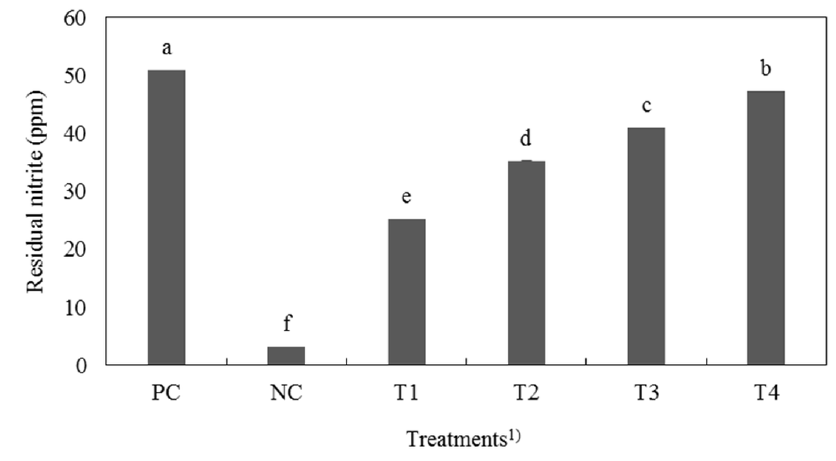
Figure 2. Residual nitrite contents of cured pork loin with natural nitrite source from fermented Swiss chard (FSC). 1) PC, positive control, 120 ppm nitrite; NC, negative control, nitrite-free; T1, FSC solution:water = 10:30; T2, FSC solution:water = 20:20; T3, FSC solution:water = 30:10; T4, FSC solution:water = 40:0. a-f Different letters on top of the column mean significant difference between treatments (p<0.05).